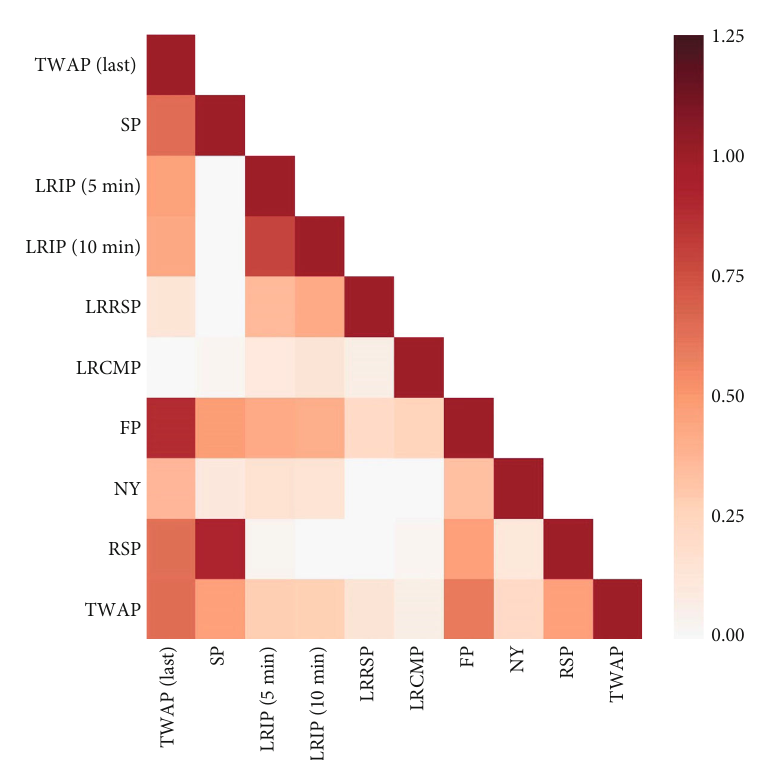
Figure 9: The Pearson correlation coe ffi